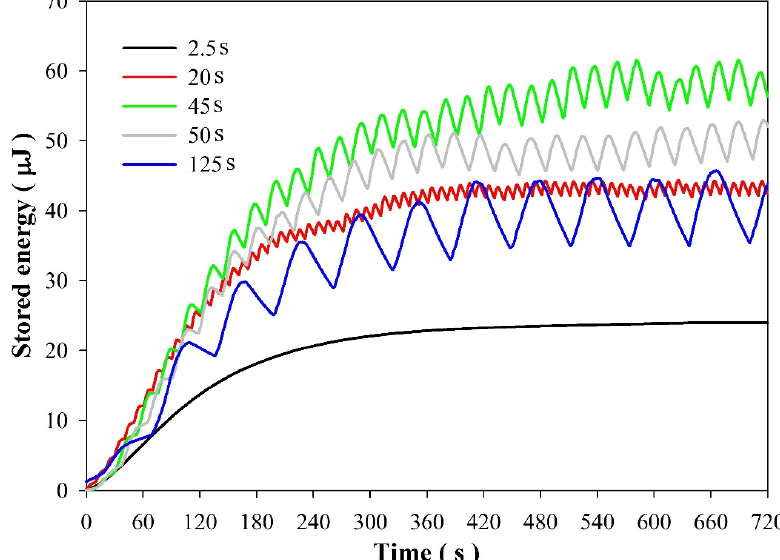
Figure 11. Relationships between the stored energy in the 10 μ F electrolytic capacitor and times of various periods for the PZT pyroelectric harvester with temperature fluctuations in the range from 55 °C to 65